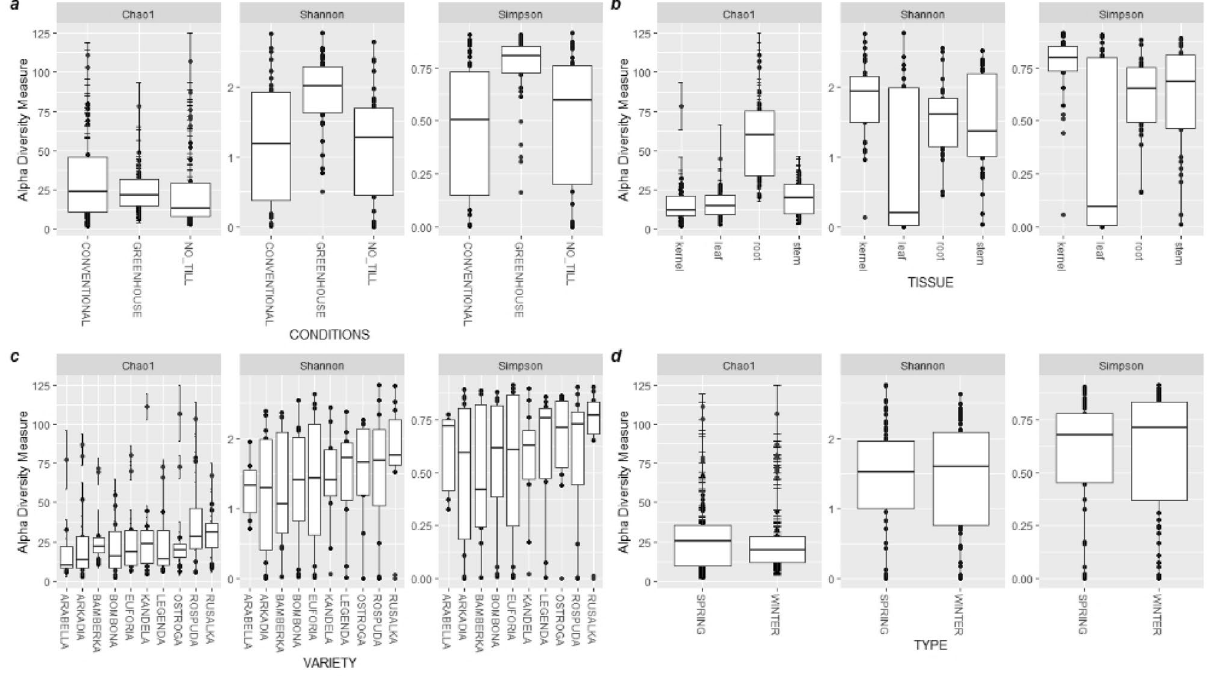
Figure 1. Alpha diversity estimates of endogenous fungi in wheat plants containing the Chao, Shannon and Simpson indices evaluation and separated based on ( a ) growth conditions, ( b ) tissue types, ( c ) cultivars, and ( d ) wheat forms by performing the Wilcoxon rank sum test using pairwise